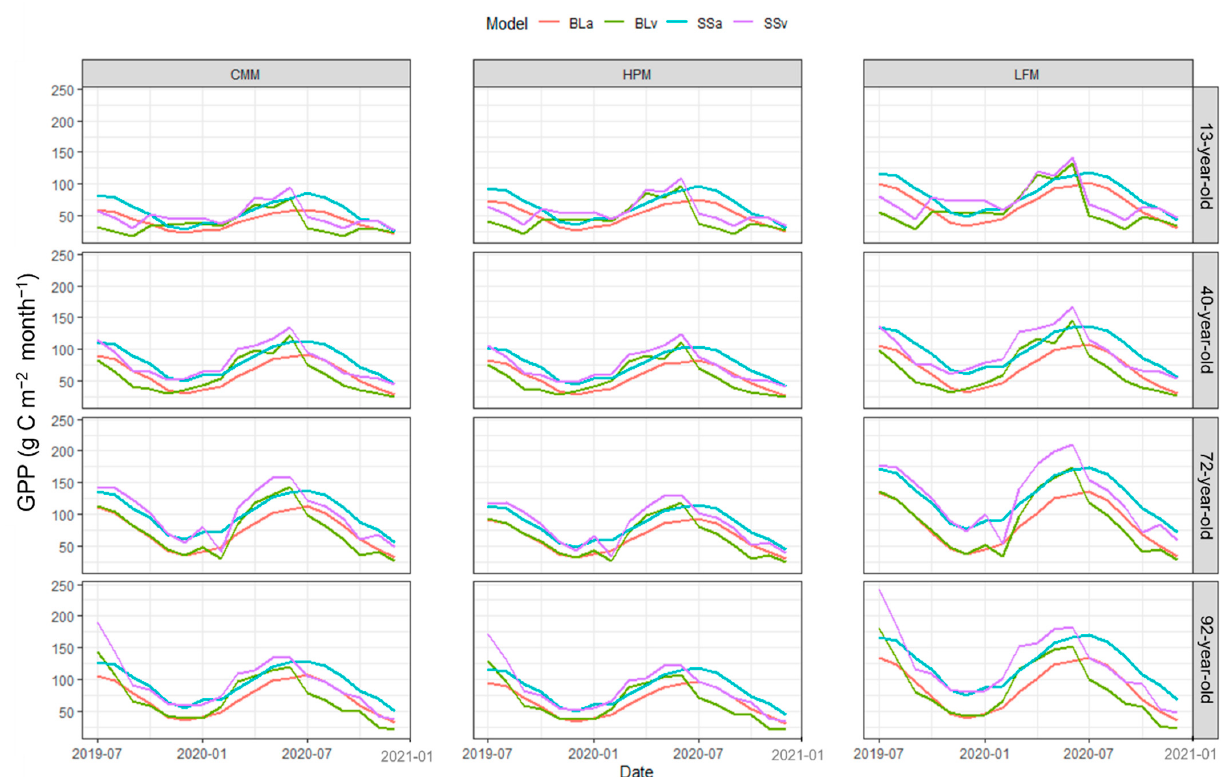
Figure 3. Gross Primary Productivity (GPP) monthly estimations for the examined period by the Big Leaf model with average A sat and K m , (BLa)—red line, Big Leaf with variation of A sat and K m (BLv)—green line, Sun/Shade model with average A sat and K m , (SSa)—blue line, and Sun/Shade model with variation of A sat and K m , (SSv)—purple line for all three methods of LAI estimation, ceptometer method (CMM), hemispherical photography method (HPM) and litterfall method (LFM).